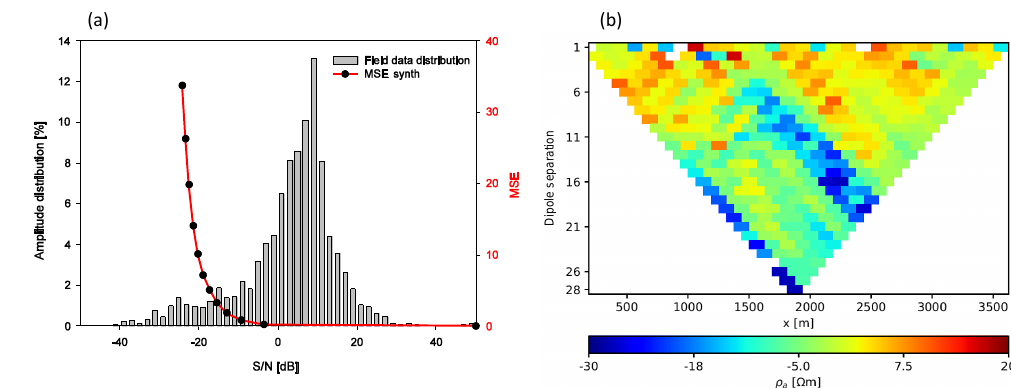
Figure 14. Signal-to-noise values of field data. (a) Histogram compared to MSE of synthetic data, (b) in a pseudo-section.